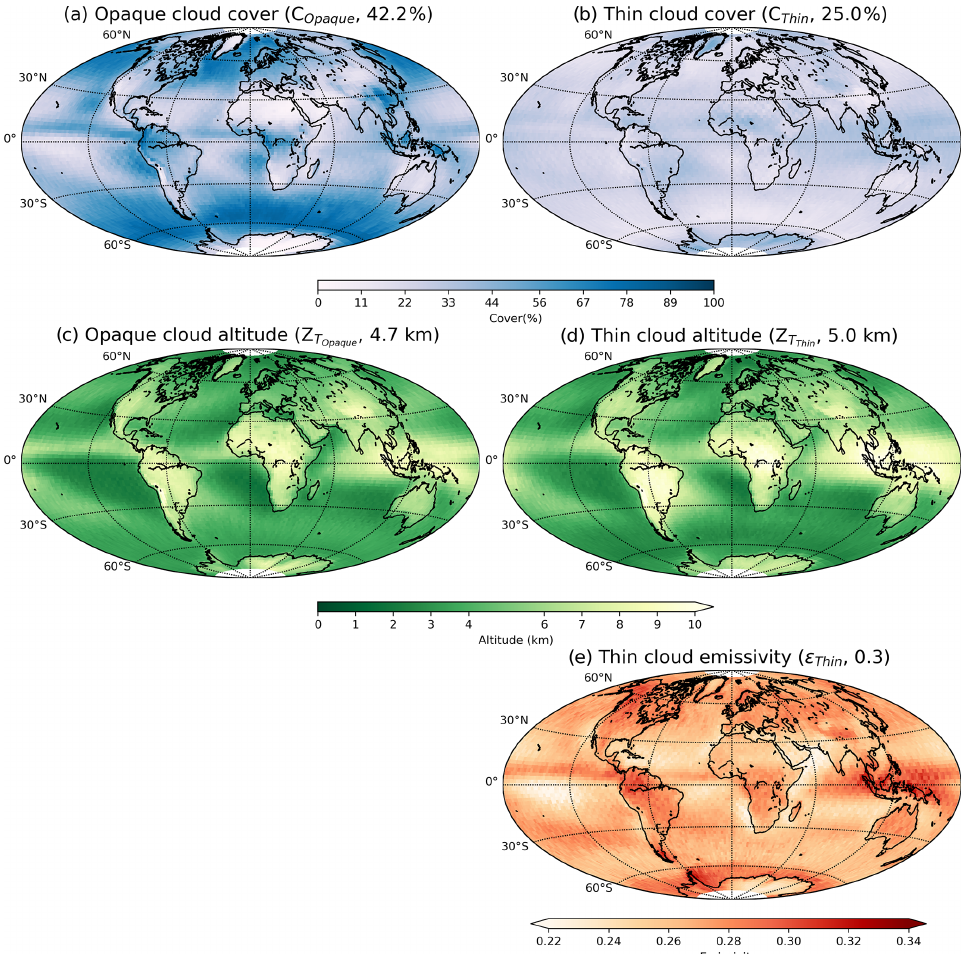
Figure 2. Maps of (a) opaque cloud cover C Opaque , (b) thin cloud cover C Thin , (c) opaque cloud altitude Z T Z T and (e) thin cloud emissivity ε Thin . Global means are reported in parentheses. Build from CALIPSO–GOCCP v3.1.2 over Thin